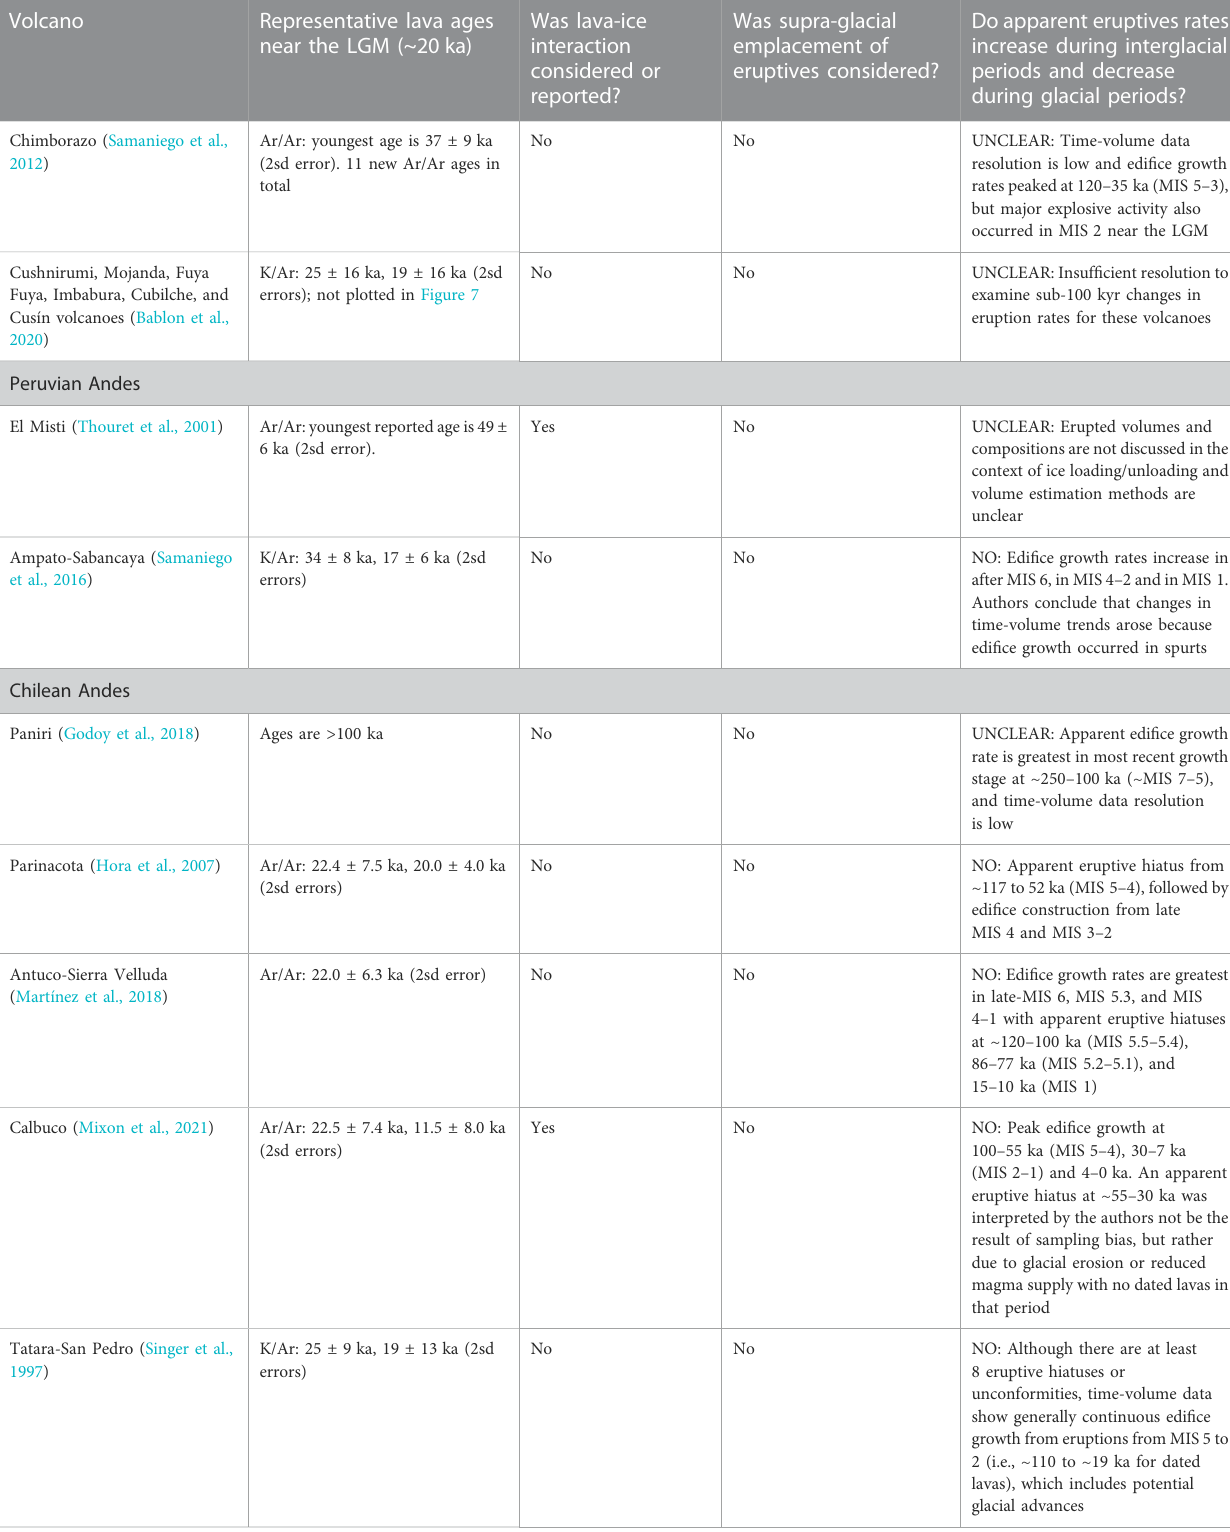
TABLE 2 ( Continued ) Summary of geochronological precision, preservation considerations, and time-volume correlations with climatic changes. The radiometric ages and other summarized information are from the references in Table 1, unless otherwise noted. Volcano Representative lava ages near the LGM (~20